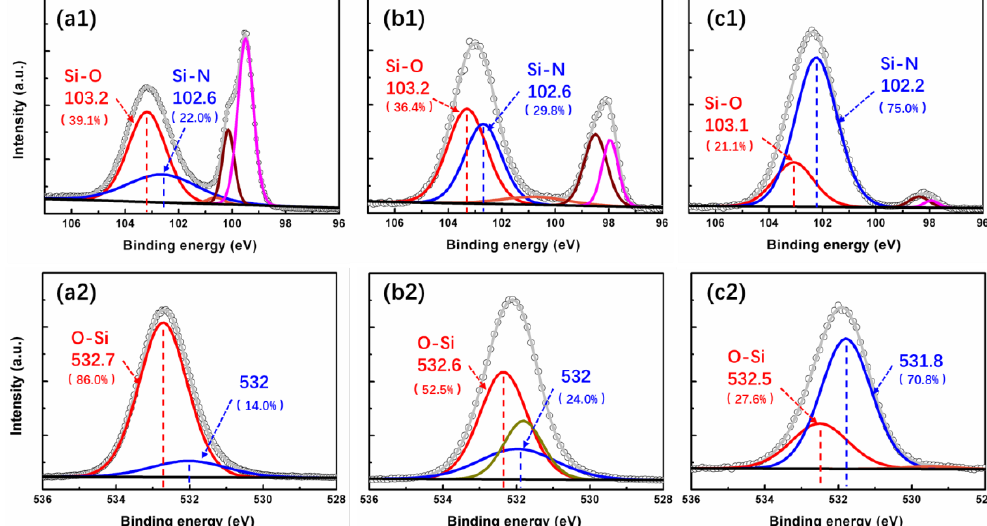
Figure 5. X-ray photoelectron spectra (XPS) of the studied samples in the energy region of N 1s levels.